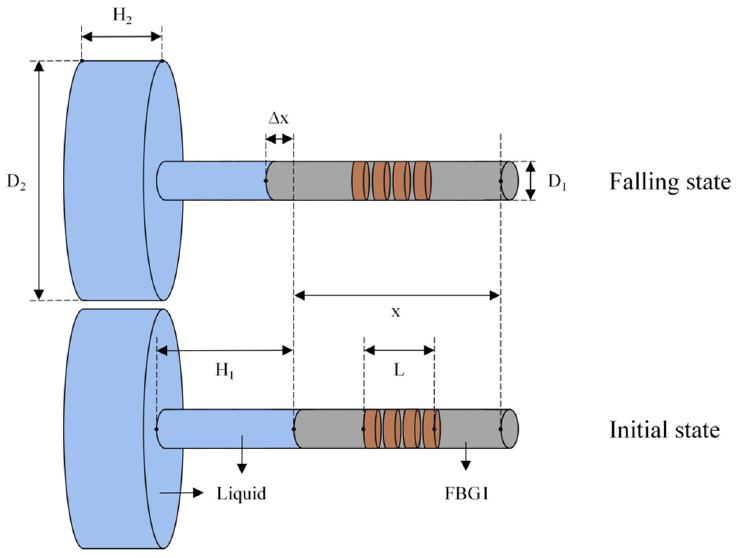
Figure 2. Schematic diagram of the deformation of the liquid column and FBG1 during the falling